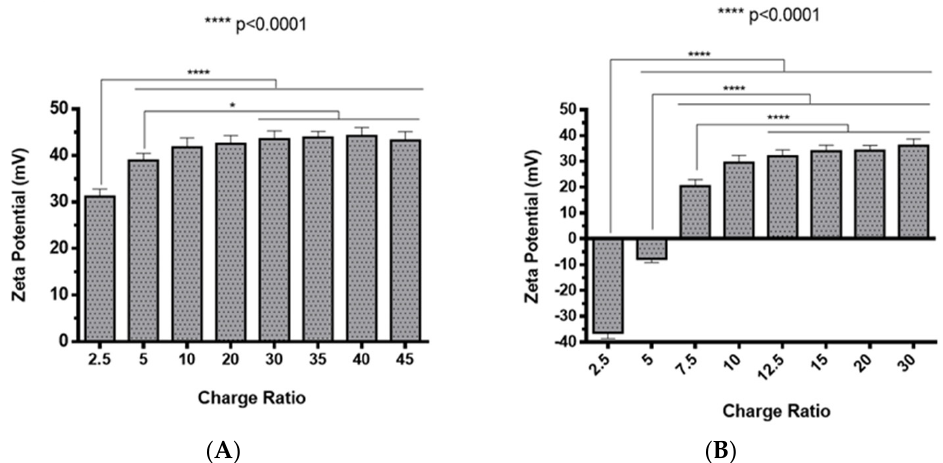
Figure 4. Zeta potential of different pre-miR-29b-loaded polyplexes at various N/P ratios in distilled water: ( A ) CS-SA/pre-miR-29b polyplexes and ( B ) PEI-SA/pre-miR-29b polyplexes. Table 1. Characterization of chitosan–stearic acid–lactoferrin (CS-SA-Lf)/pre-miR-29b and